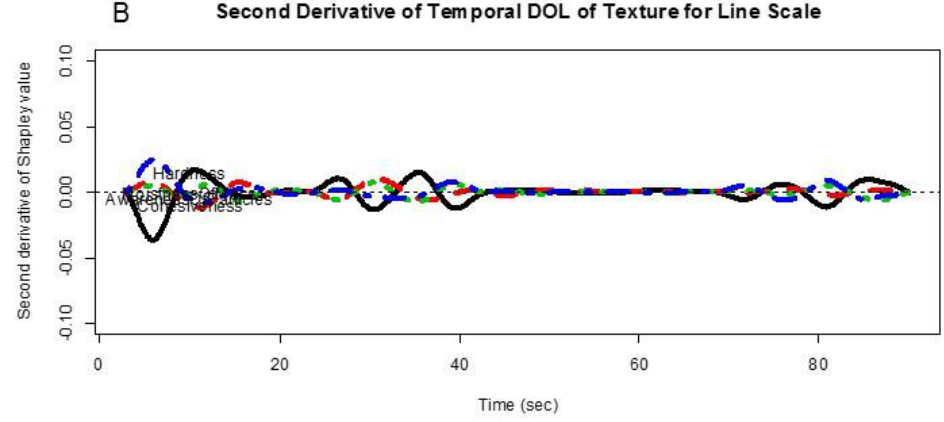
Figure 10. Derivatives of temporal drivers of Overall Liking of Texture with line scale. ( A ) First Derivative and ( B ) Second Derivative.